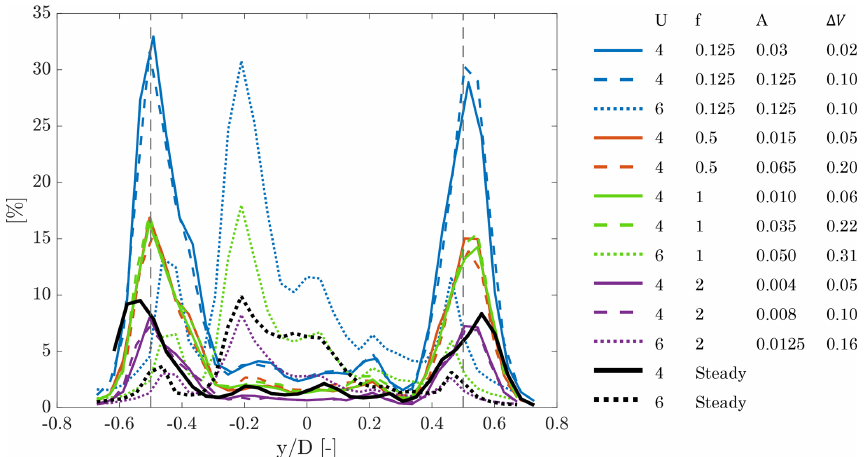
Figure 13. Frequency-averaged PSD of the hub-height axial velocity in different cross-wind positions ( y/D = 0 corresponds to the hub location, and the rotor edge is marked by the vertical dashed lines). In the legend U is the mean wind speed, f the surge frequency, A the surge amplitude, and (cid:49)V the maximum surge velocity.